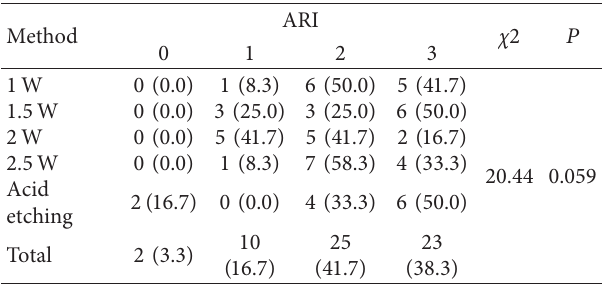
Table 6: Association between ARI scores and the different etching groups.